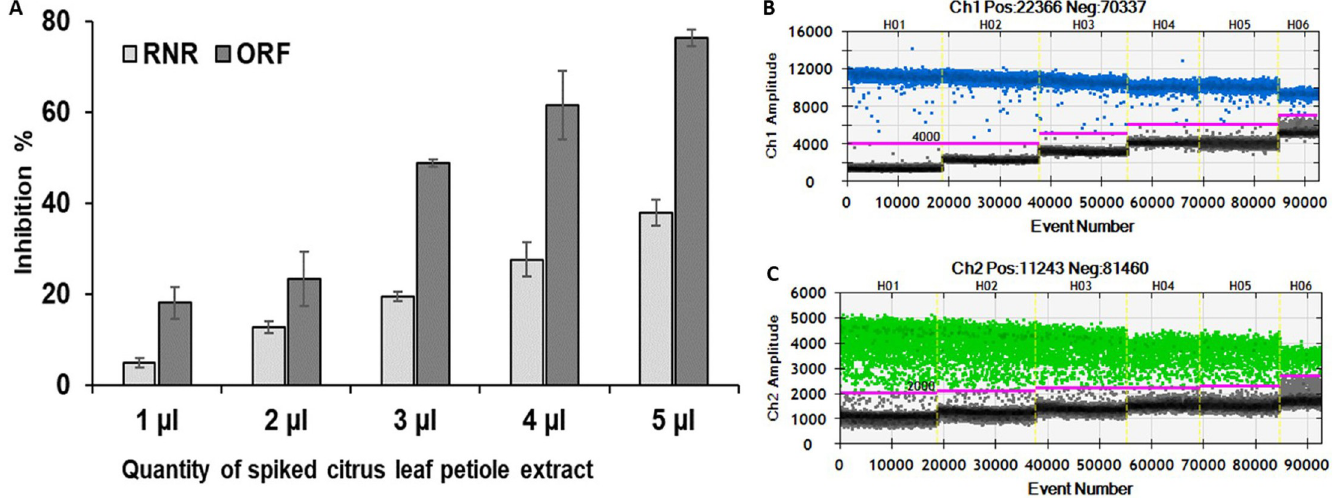
Fig 8. Influence of citrus leaf petiole extract on quantification of “ Candidatus Liberibacter asiaticus” and Spiroplasma citri by duplex ddPCR assays for RNR gene and ORF1 gene respectively. (A) ddPCR reaction mixture was spiked with different quantity of citrus leaf petiole extract and equal amount of citrus leaf DNA. Error bars denote standard error of inhibition between three replicates of each reaction. (B, C) one dimensional plot showing only one of three replications for RNR gene and ORF1 gene with citrus leaf petiole extracts.